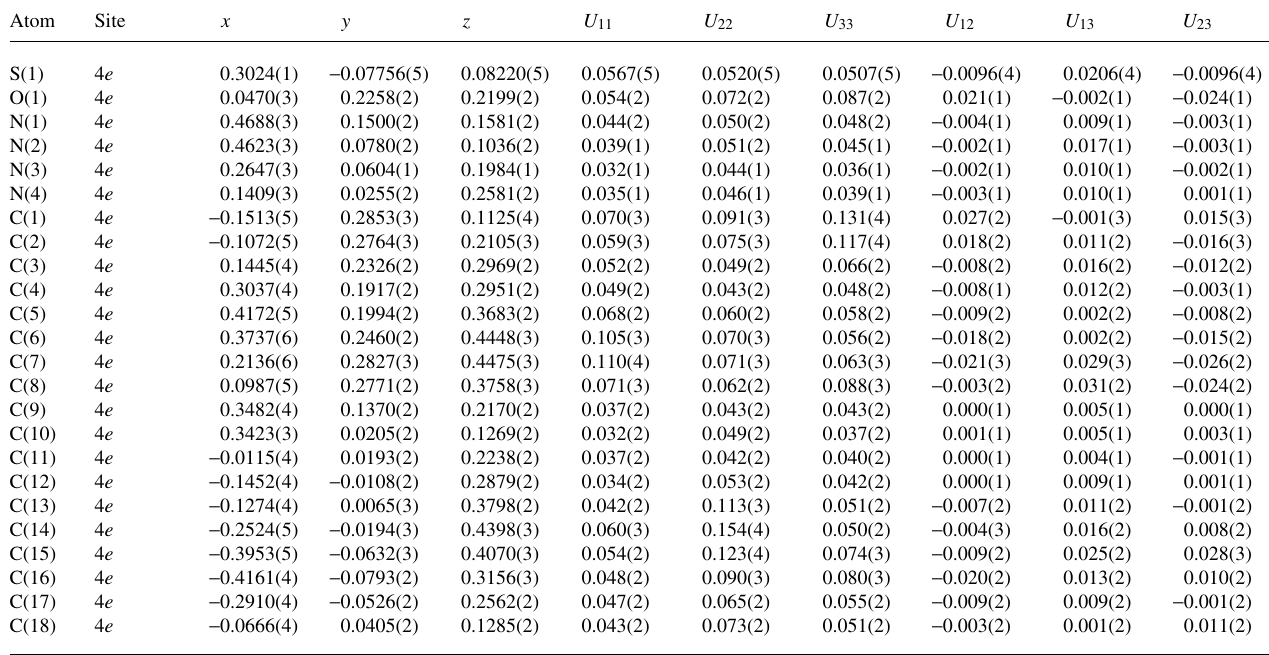
Table 3. Atomic coordinates and displacement parameters (in Å 2 ) .